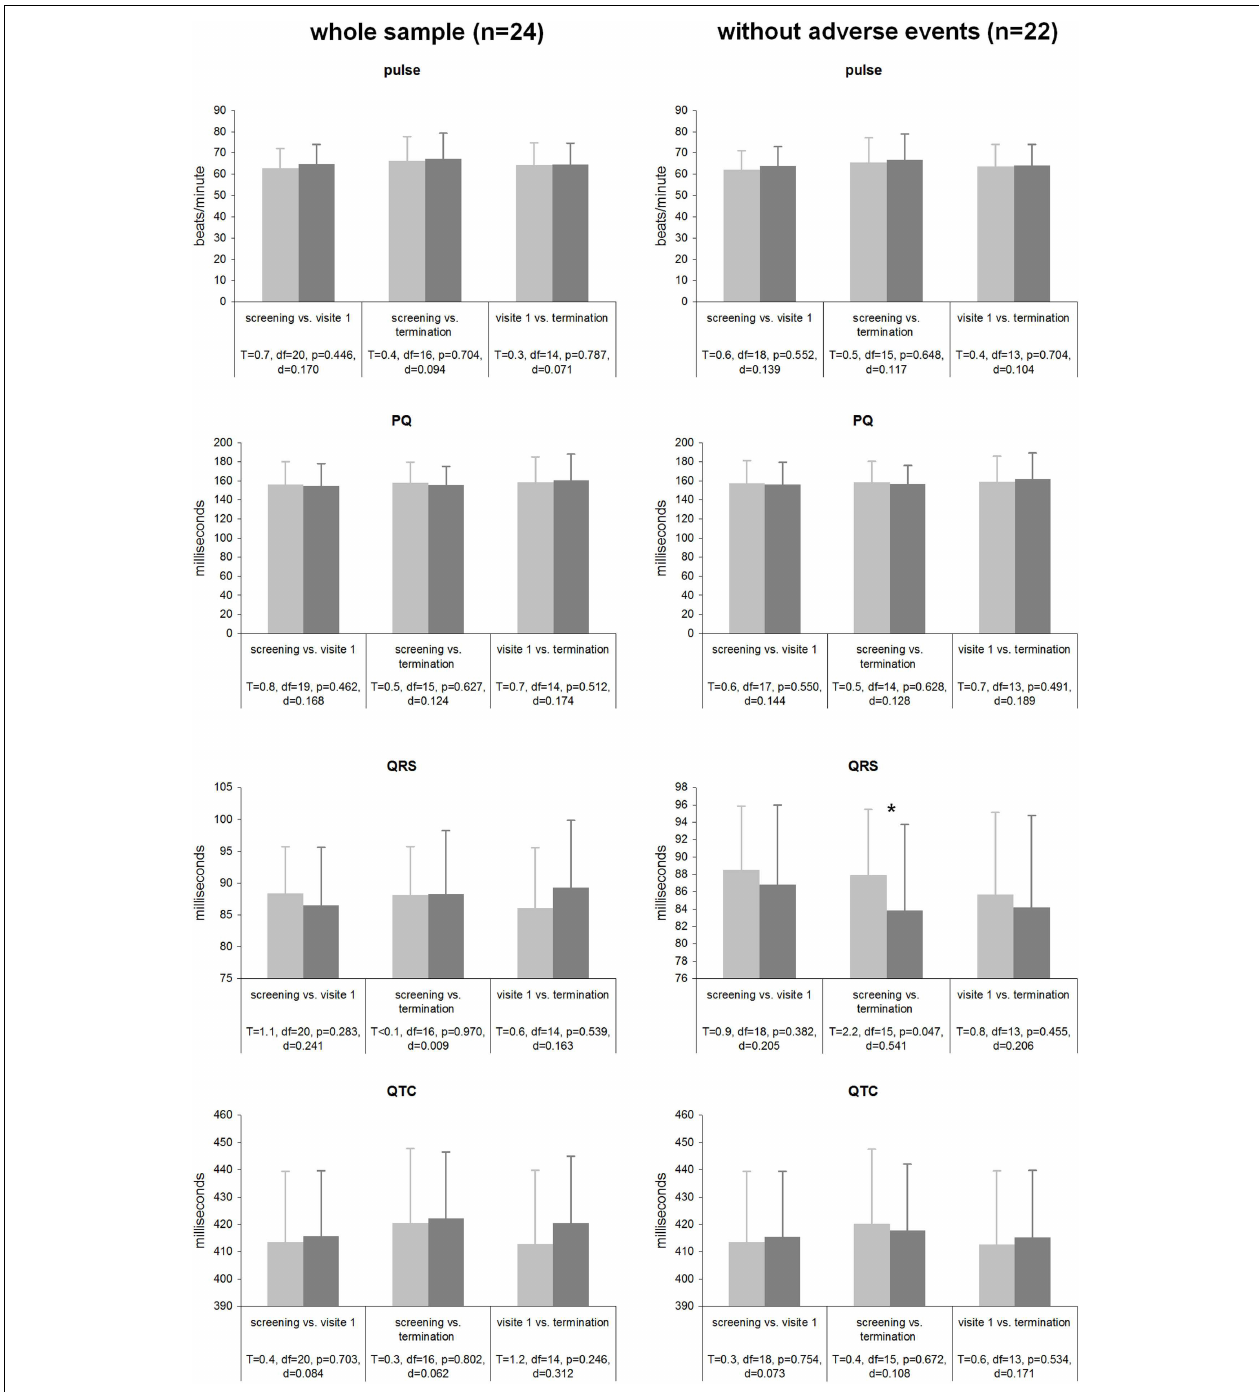
FIGURE 4 | Cardiac parameters during tVNS stimulation for both the whole sample and the sample without the 2 patients experiencing adverse cardiac events.